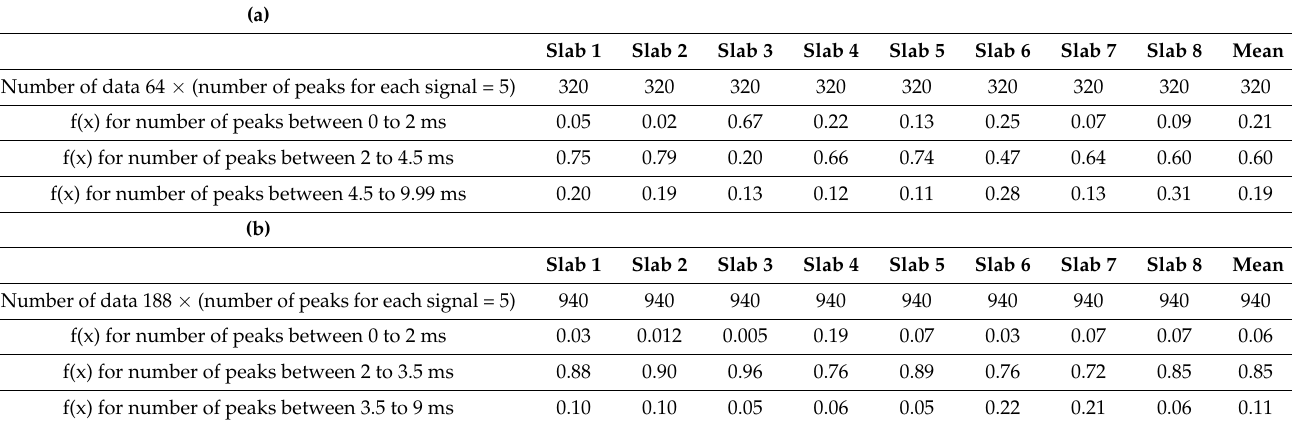
Normalized energy